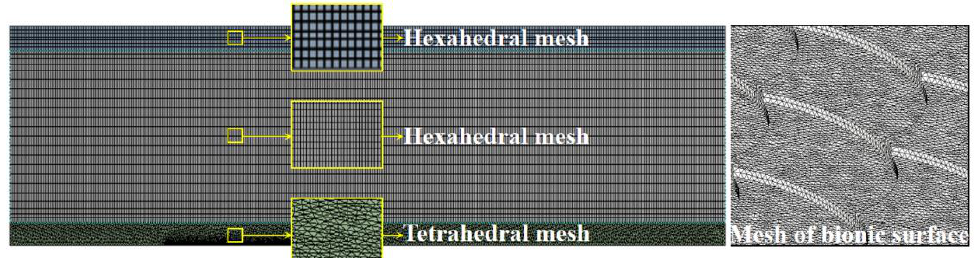
Figure 9. Mesh image of the whole computational region and local bionic surface.